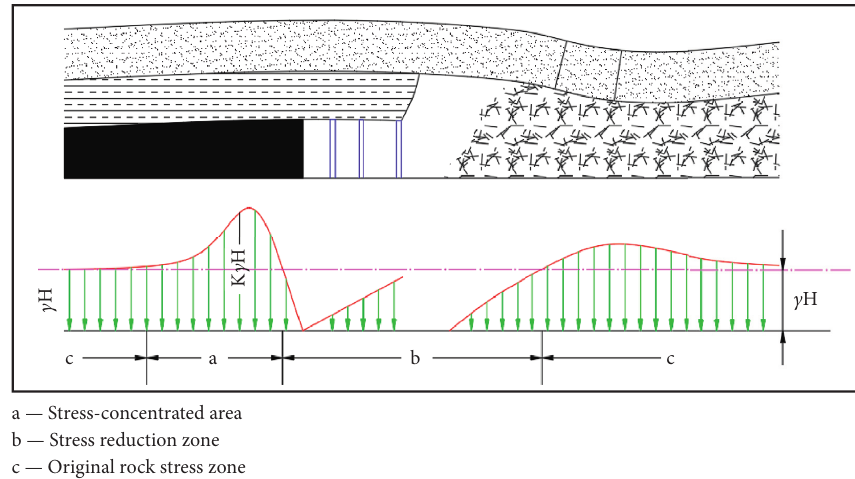
Figure 3: Distribution of bearing stress before and after the working face.